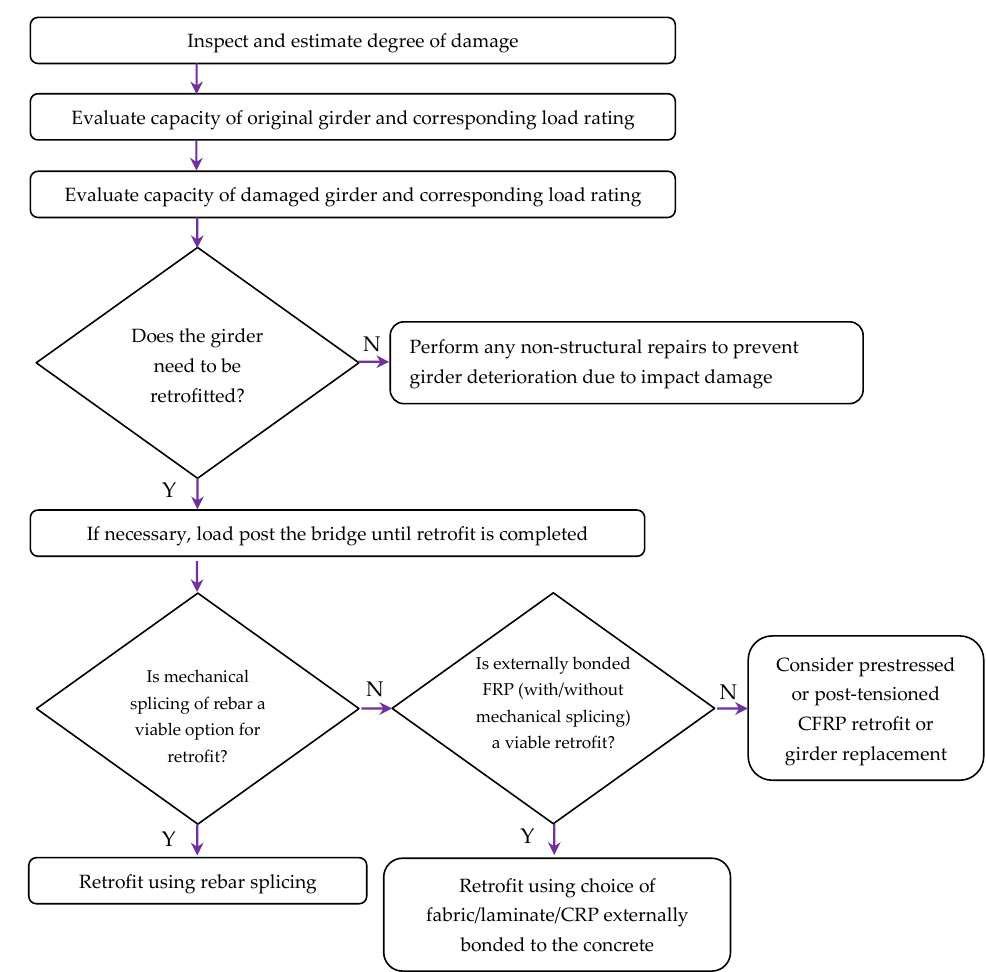
Figure 4. RC girder retrofit process following over ‐ height truck impact.